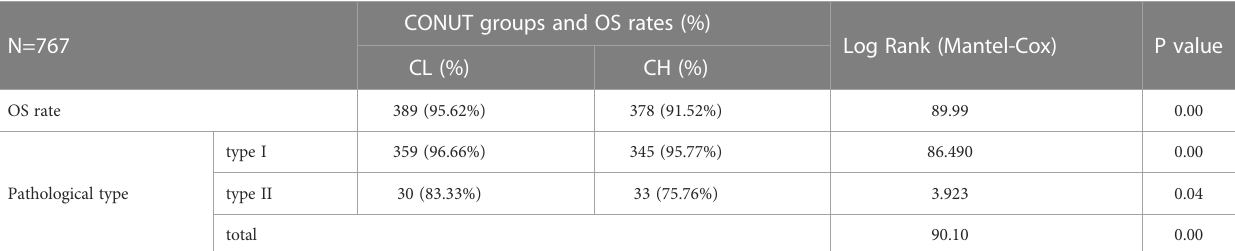
CONUT groups and OS rates